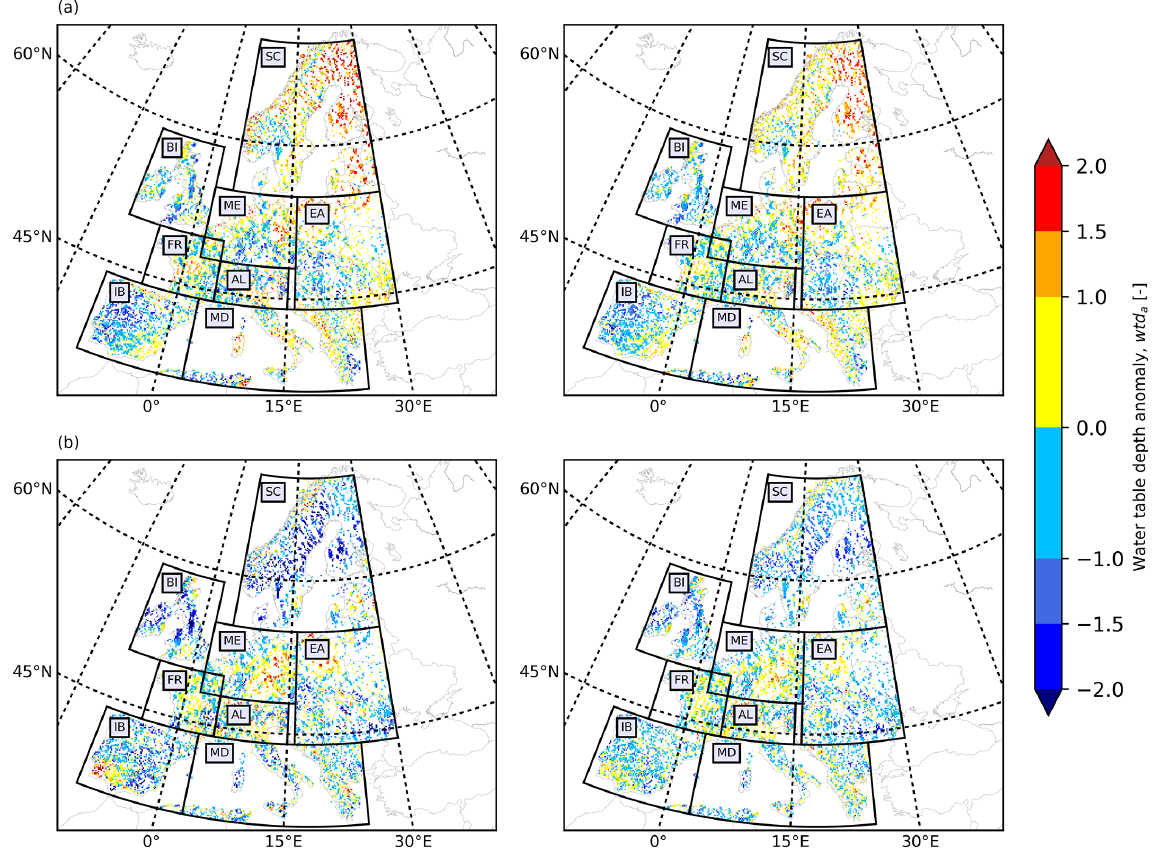
Figure B1. European wtd a maps for (a) July 2003 (i.e., in the training period) and (b) July 2015 (i.e., in the testing period) derived from the TSMP-G2A data set (left) and the results from LSTM networks